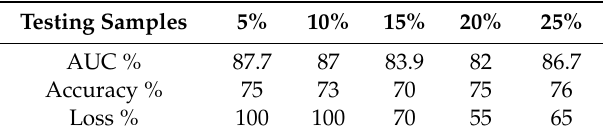
Table 3. LSTM neural network model and decision support systems (DSS) reading automatism: area under the curve (AUC), accuracy, and loss results.